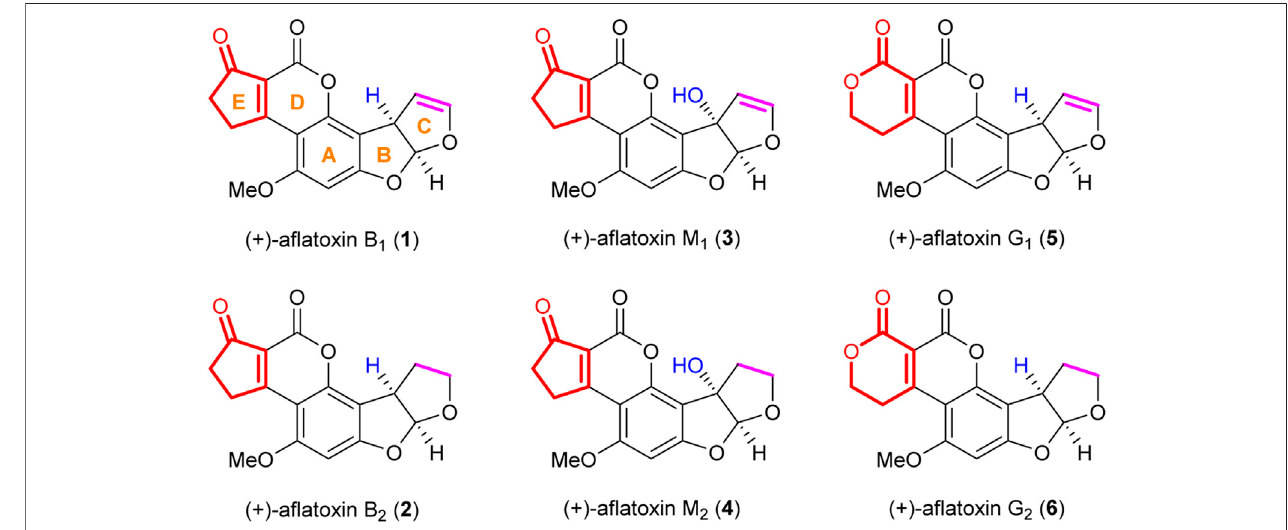
FIGURE 1 | Structures of representative a fl atoxins.